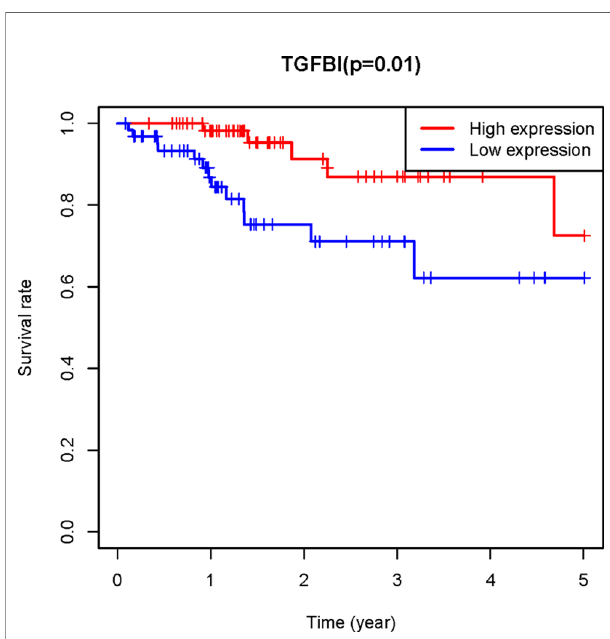
FIGURE 9 | The Kaplan – Meier analysis. the Kaplan – Meier analysis of the patients from TCGA COAD receiving chemotherapy showed the survival of patients with high expression of TGFBI is better than those patients with low expression of